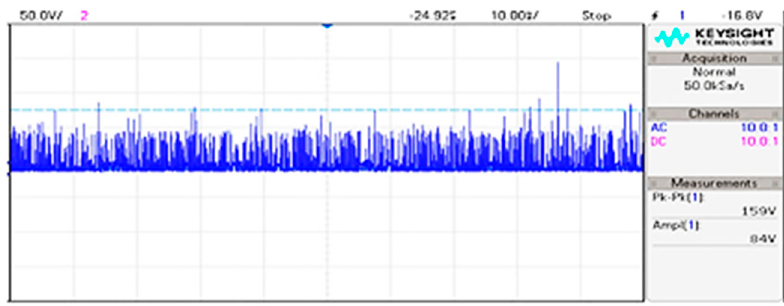
Figure 21. Voltage across cross-coupled capacitors of ZSI (50 V/Div).